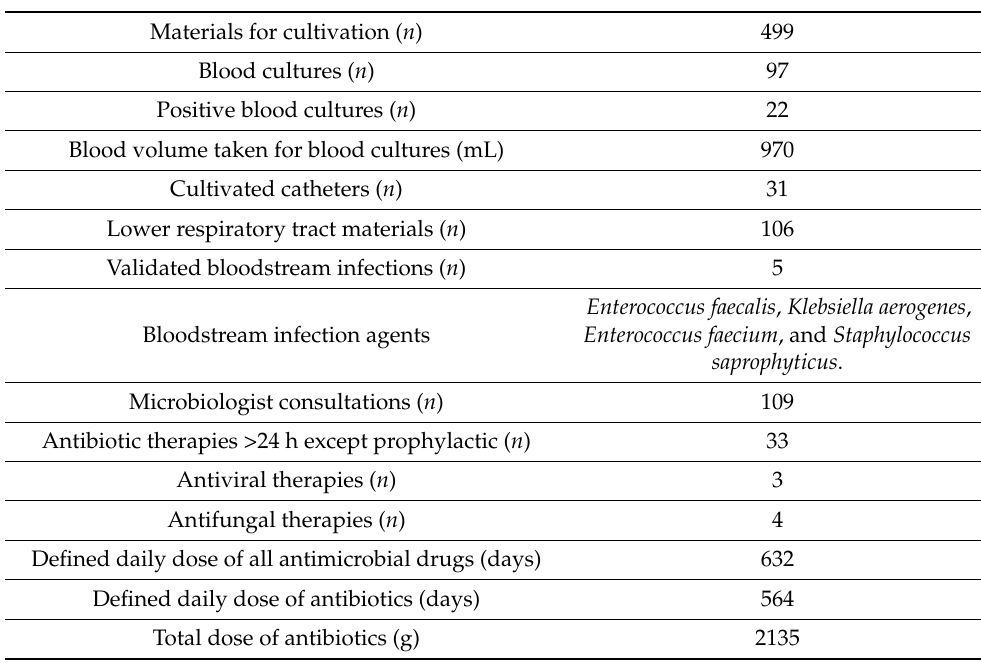
Table 1. Details of antimicrobial therapy during 207 days of VV-ECMO support until lung transplan- tation.